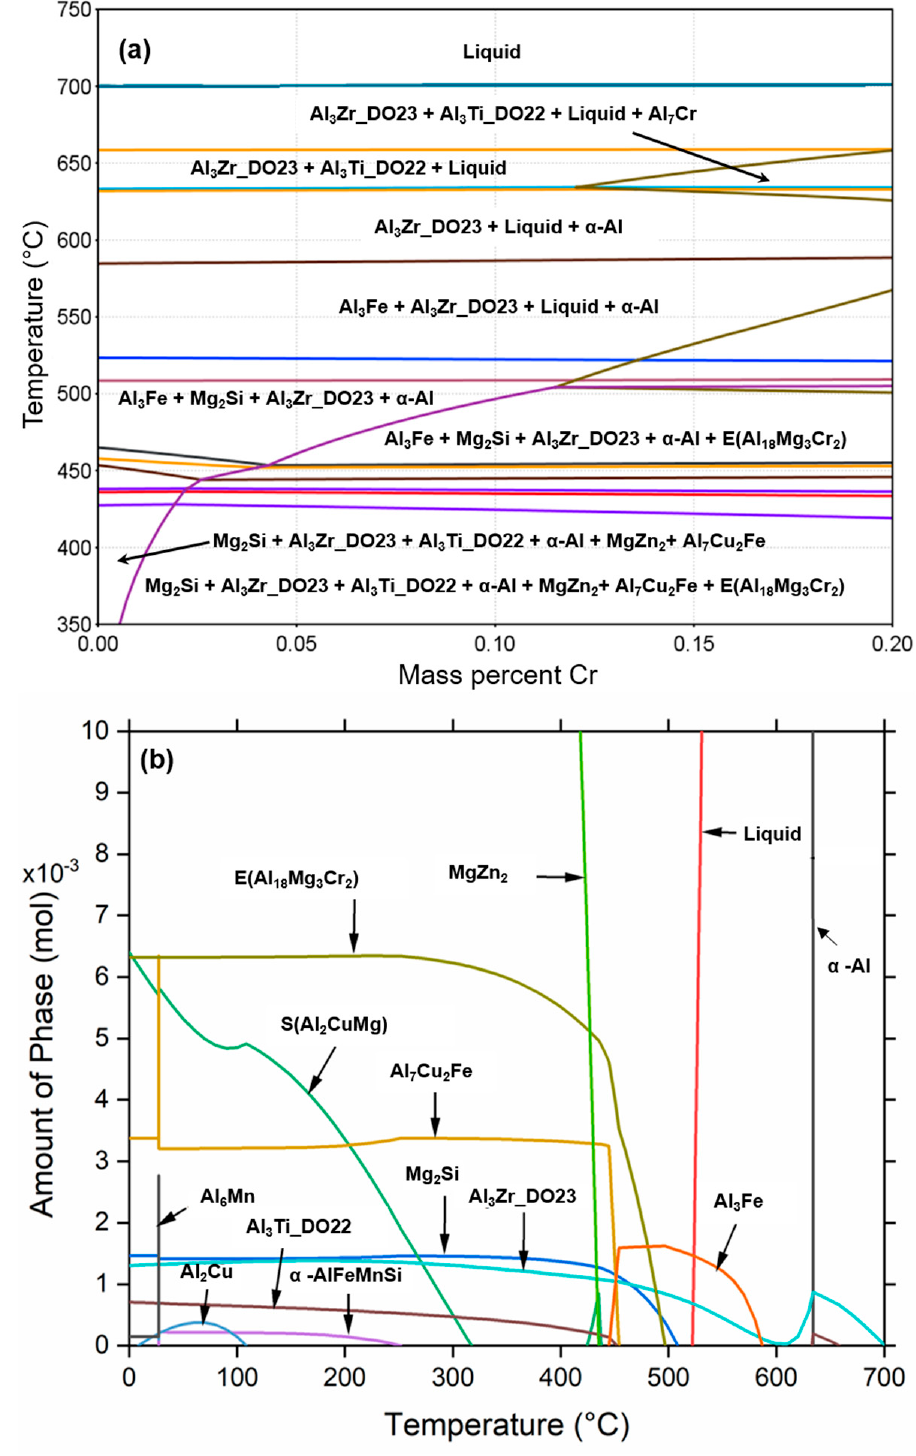
Figure 2. Thermodynamic simulation results: ( a ) phase diagram of 7449 alloy with Cr addition; ( b ) phase equilibrium of 7449 + 0.1 wt.% Cr replotted with OriginPro.